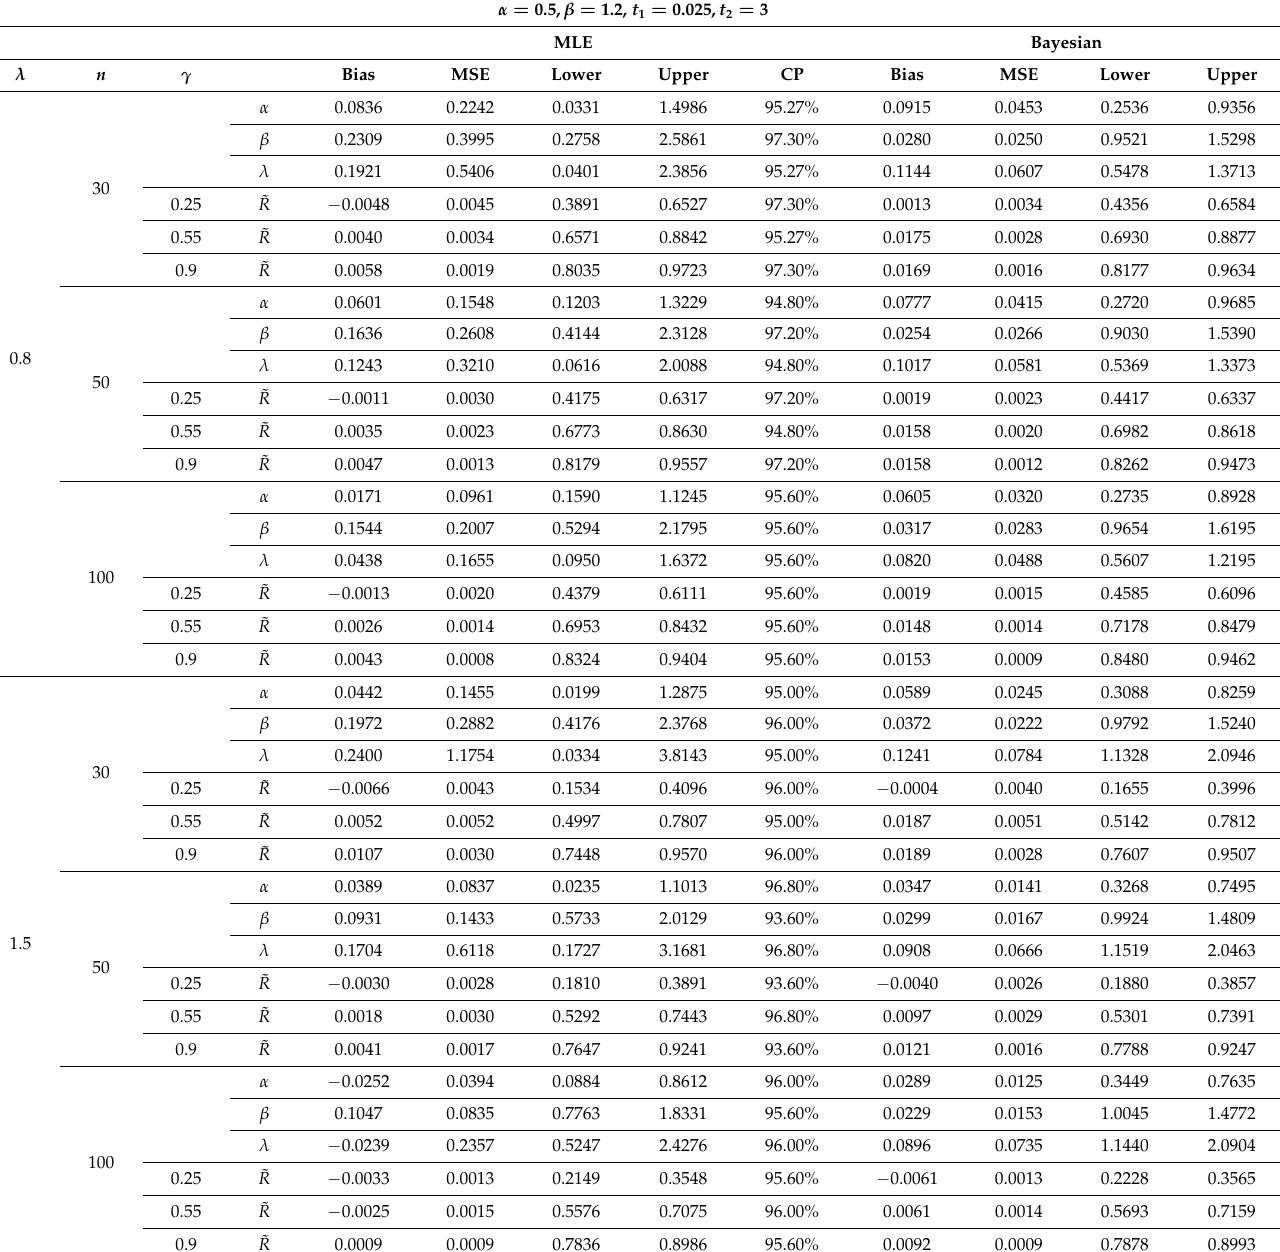
Table 1. Bias, MSE, and CI for fuzzy reliability and parameters of model in case